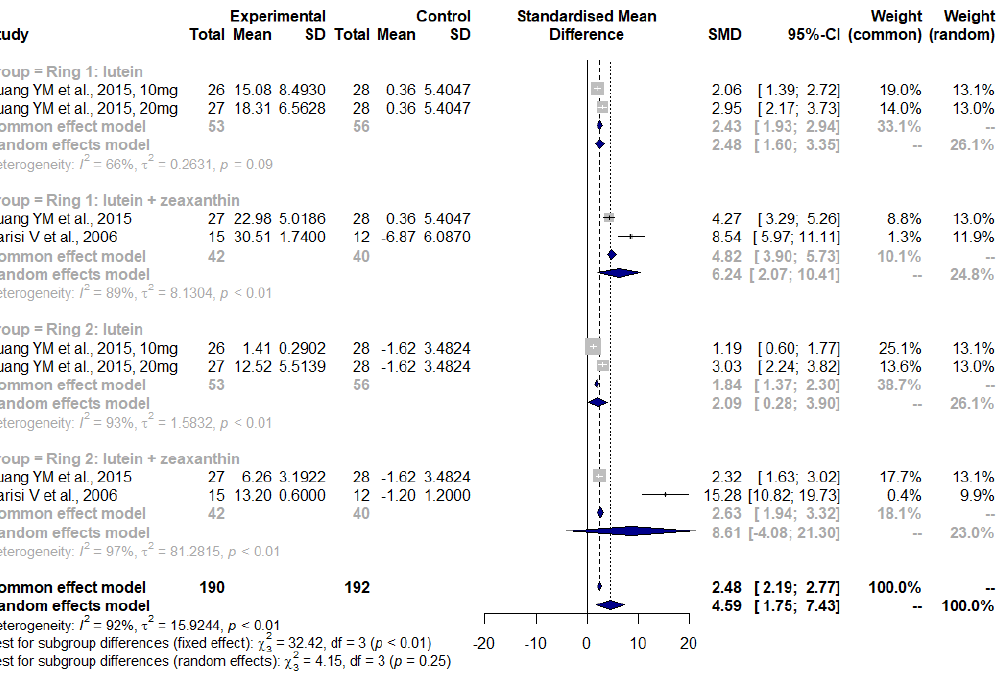
Figure 4. Forest plot of mfERG outcomes in studies where subjects were administered either lutein or lutein plus zeaxanthin; SD, standard deviation; SMD, standardized mean difference; CI, confidence interval